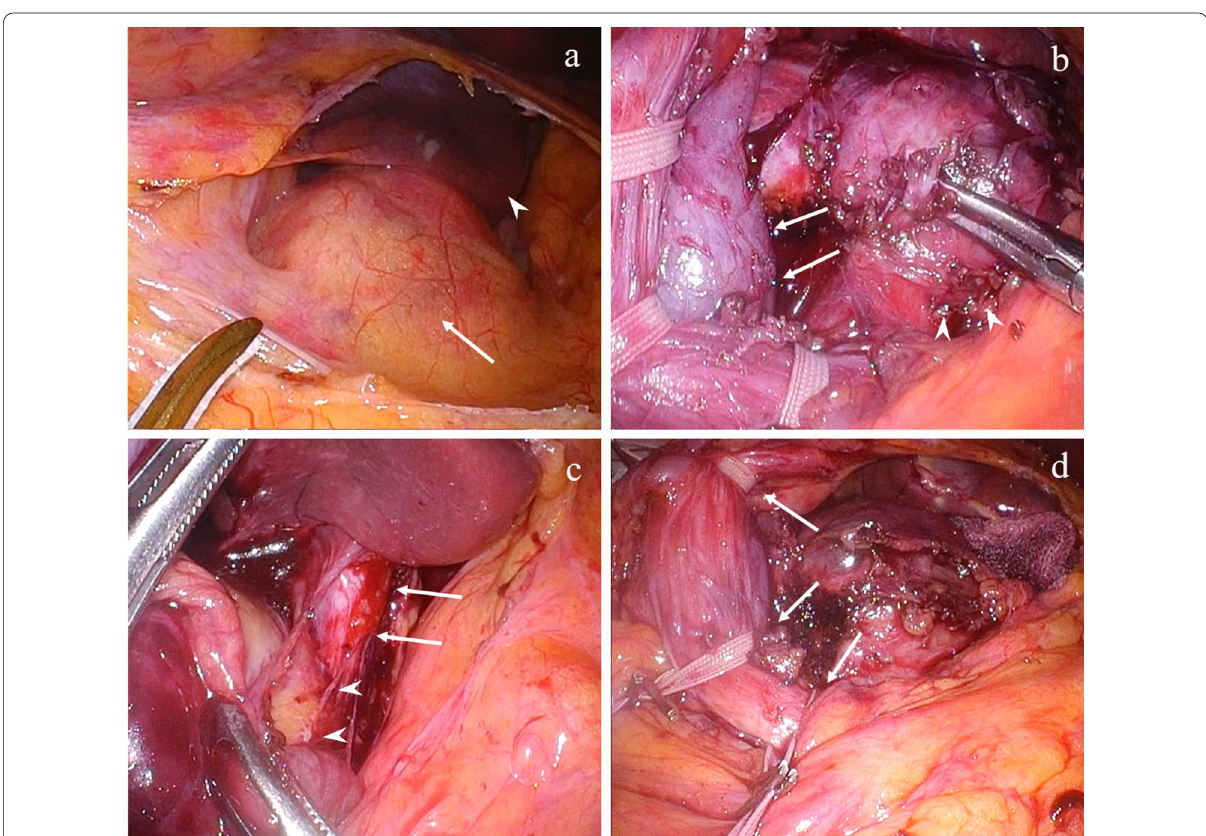
Fig. 4 Intraoperative findings. a The first observation of the tumor (white arrow), before the resection, is observed. The tumor was located under the caudate lobe of the liver (white arrowhead). b , c The tumor (white arrowhead) was located on the left side of the portal vein (white arrow) and on the ventral side of the inferior vena cava (white arrow). d The strings taping the proper hepatic artery and common hepatic artery (white arrow) were used for